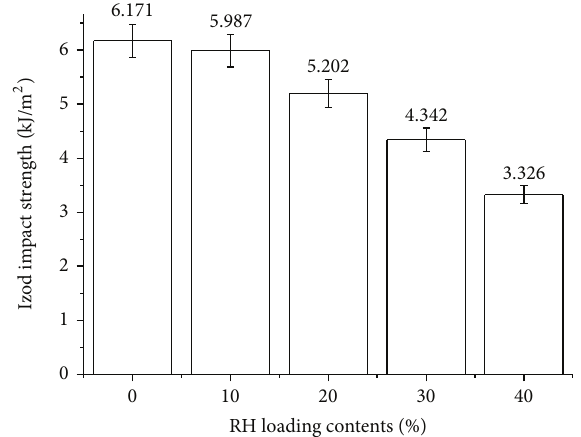
Figure 4: Impact strength of composites with different loading of rice husk